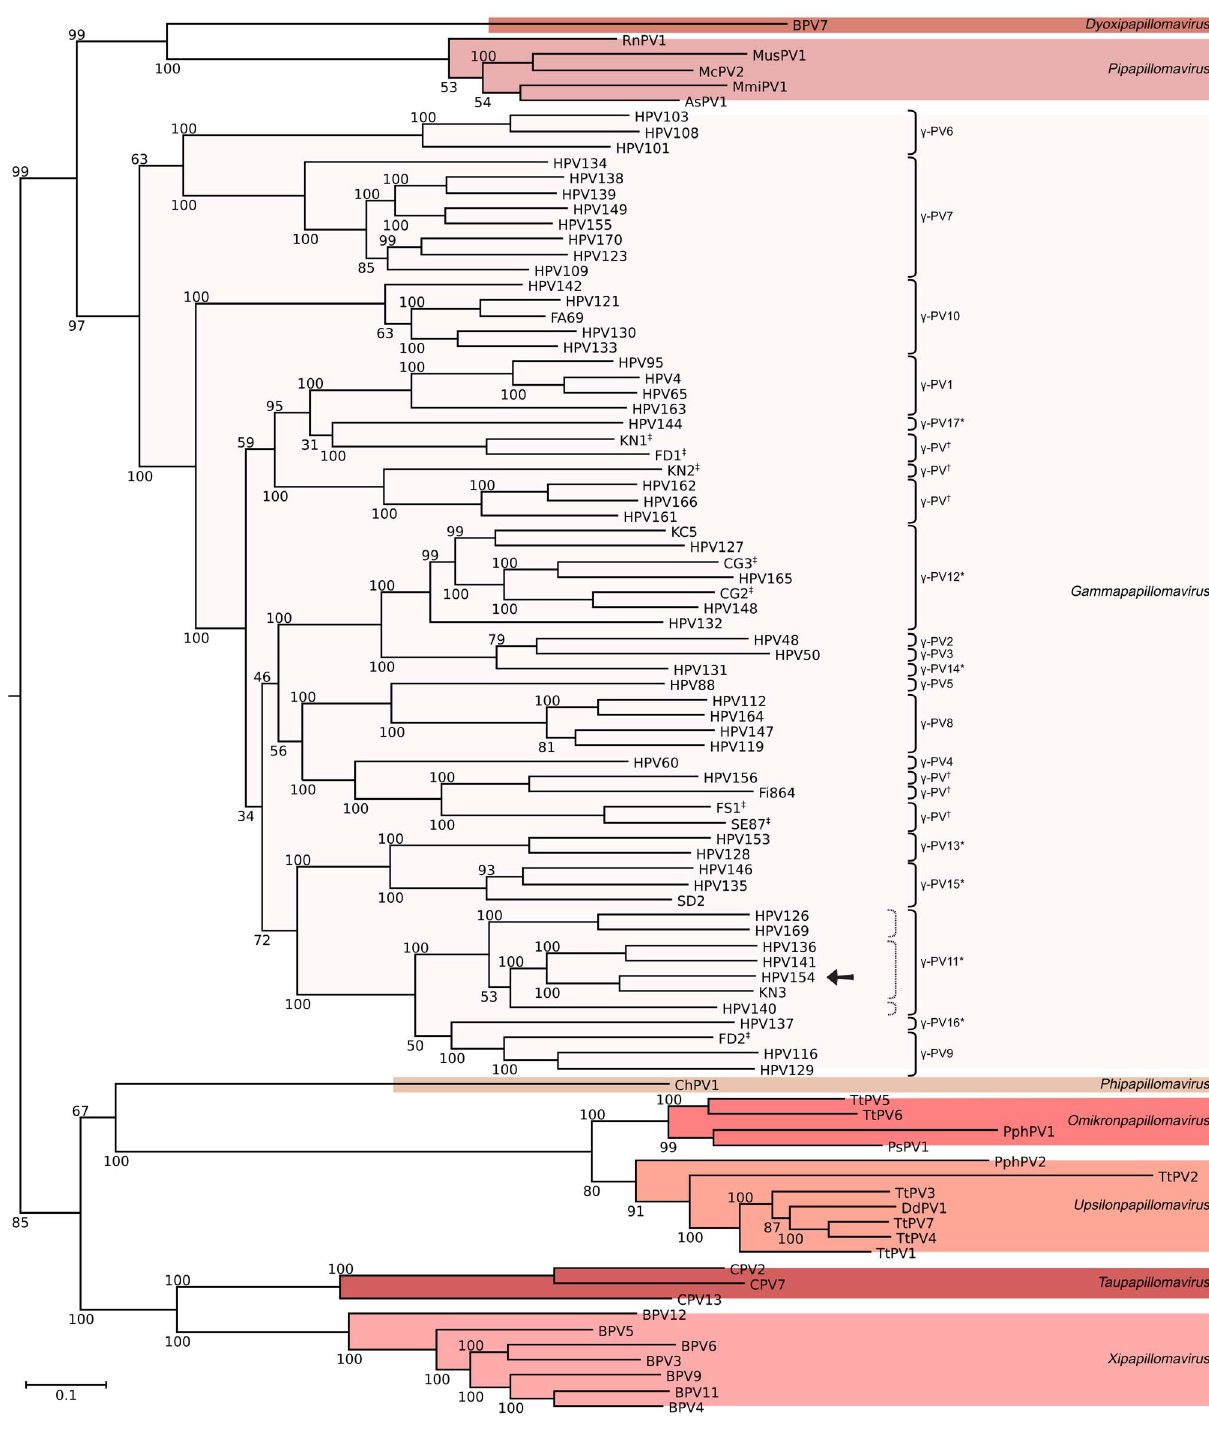
Figure 2. Phylogenetic tree for HPV154 and related papillomaviruses. Ninety one complete genomes were analyzed, including all gammapapillomaviruses as well as related genera but closer than betapapillomaviruses. HPV154 is indicated with an arrow. The tree was obtained by the maximum likelihood approach using RAxML software and rooted with the betapapillomavirus HPV5 and HPV9. Bootstrap support values are indicated in each branch as percentages. Genera are indicated at the rightmost side, while species of c -PVs are to the right of brackets. The dotted key to the left of c -PV11* shows species suggested in this work. The bar indicates the number of substitutions per site. * Proposed category and pending approval by ICTV. { Putative novel species. ` : Uncloned HPV genome (not official type). The following species are represented by the types included in the tree: AsPV1, Apodemus sylvaticus papillomavirus 1 ; BPV, Bos taurus papillomavirus spp. ; ChPV1, Capra hircus papillomavirus 1 ; CPV, Canis familiaris papillomavirus spp. ; DdPV1, Delphinus delphis papillomavirus 1 ; HPV, Gammapapillomavirus spp. ; McPV2, Mastomys coucha Papillomavirus 2 ; PphPV, Phocoena phocoena papillomavirus spp. ; PsPV1, Phocoena spinipinnis Papillomavirus 1 ; TtPV, Tursiops truncatus Papillomavirus spp .